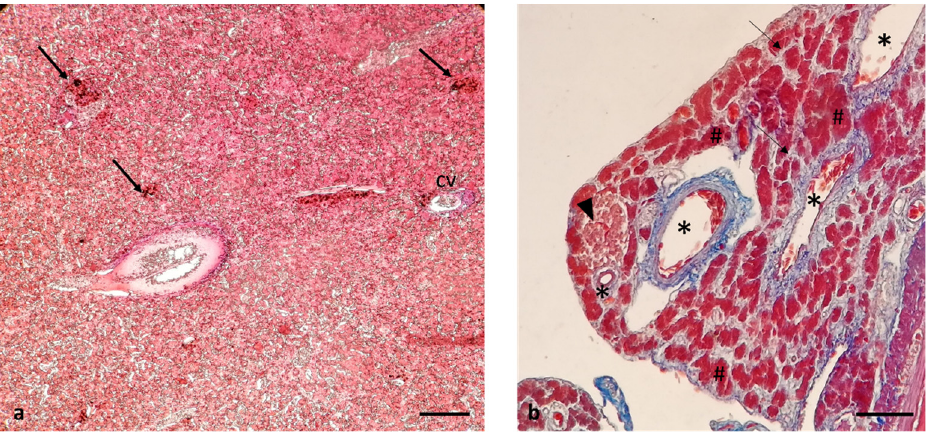
Figure 13. Masson Trichrome with Aniline Blue staining. ( a ) Micrograph of the liver: scattered melano-macrophage centers also known as macrophage aggregates (arrows), central lobular vein (cv). ( b ) micrographs of the pancreas: connective septa (arrows), acini formed by secretory cells (#), insular endocrine component (arrowhead) near the vessels (asterisks). Scale bar: 5 μ m ( a ), 50 μ m ( b ).